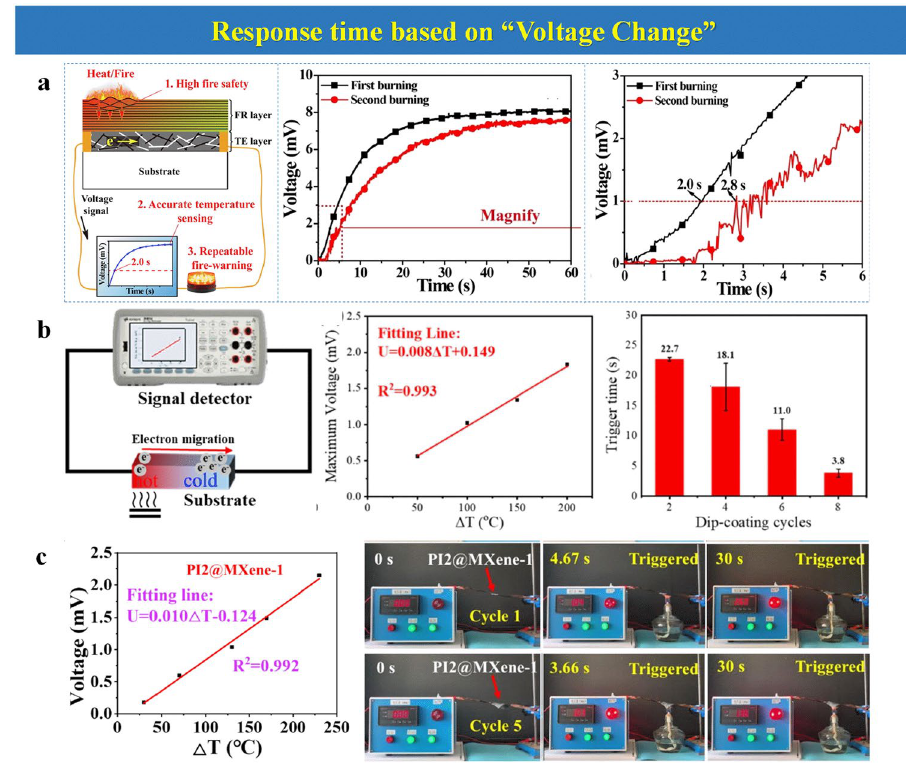
Fig. 5 a Schema illustration of a fire‑warning nano‑coating; output voltage curve over heating time in the first and second heating test. Repro‑ duced with permission from Ref. [55]. Copyright 2021 Elsevier B.V. b Scheme illustration of thermoelectric effect. The relationship between voltage and temperature difference. Reproduced with permission from Ref. [67]. Copyright 2022 Elsevier B.V. c The trigger time of matrix with different dip‑coating cycles. Reproduced with permission from Ref. [35]. Copyright 2022 Elsevier